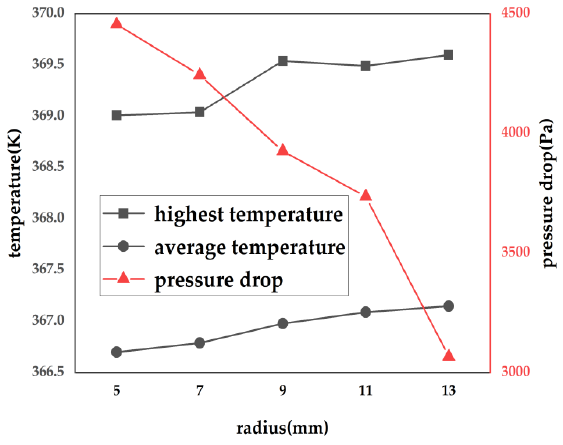
Figure 14. Change of the temperature and the pressure drop with radius.